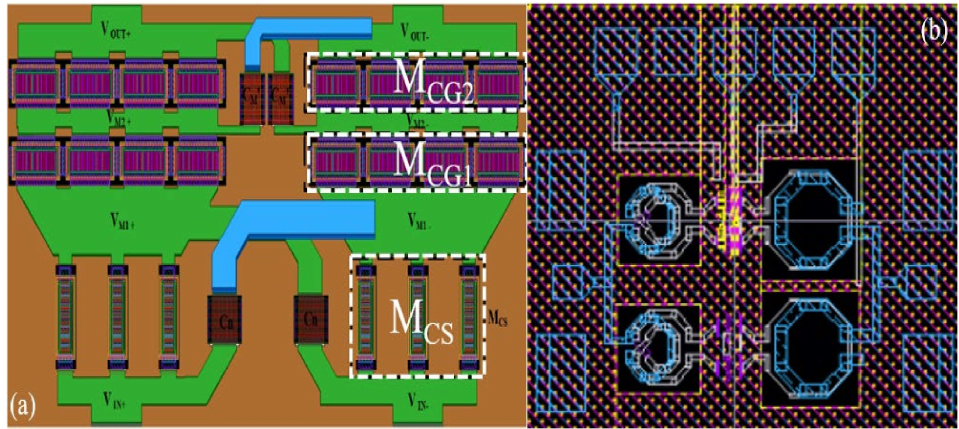
Figure 6. PA’s overall layout and core layout: ( a ) core layout; ( b ) overall layout.